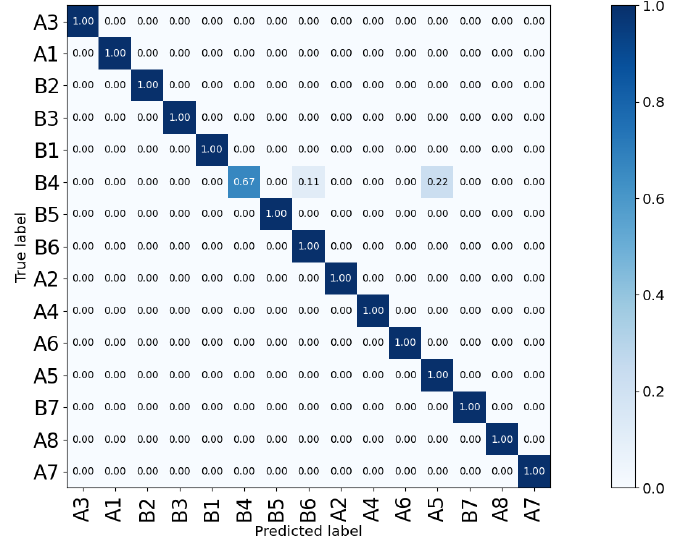
Figure 18. Confusion matrix describing the prediction accuracy based on the augmented dataset Coventry-2018 for the 15-class problem using the large-layout Sensor-1